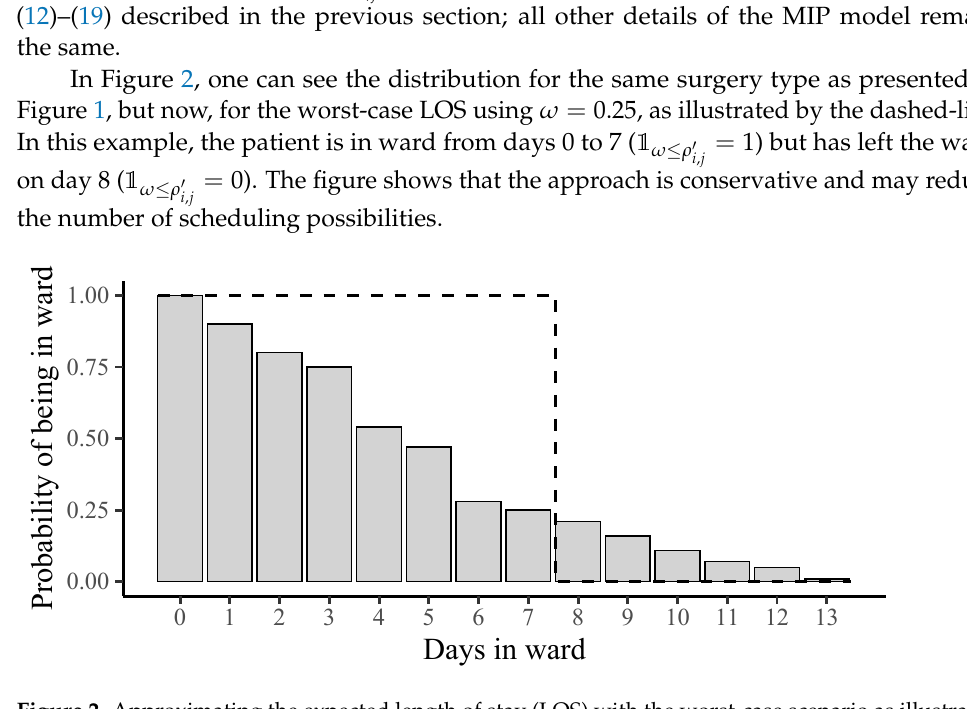
Figure 2. Approximating the expected length of stay (LOS) with the worst-case scenario as illustrated by a dashed-line using certainty ω =